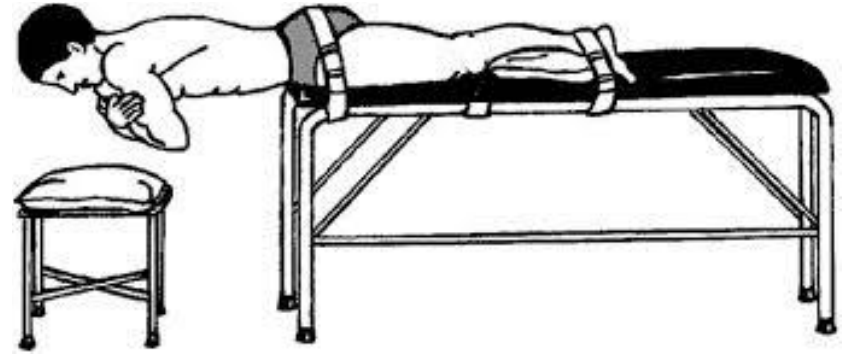
Figure 2. Biering-Sorensen schematic demonstrating body position and restraining belts [52].